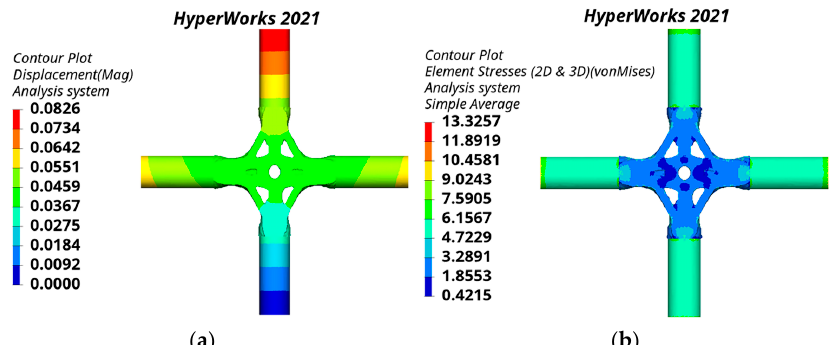
Figure 14. Static analysis results of the bionic-based substructure topology-optimized joint: ( a ) displacement nephogram, ( b ) equivalent stress nephogram.